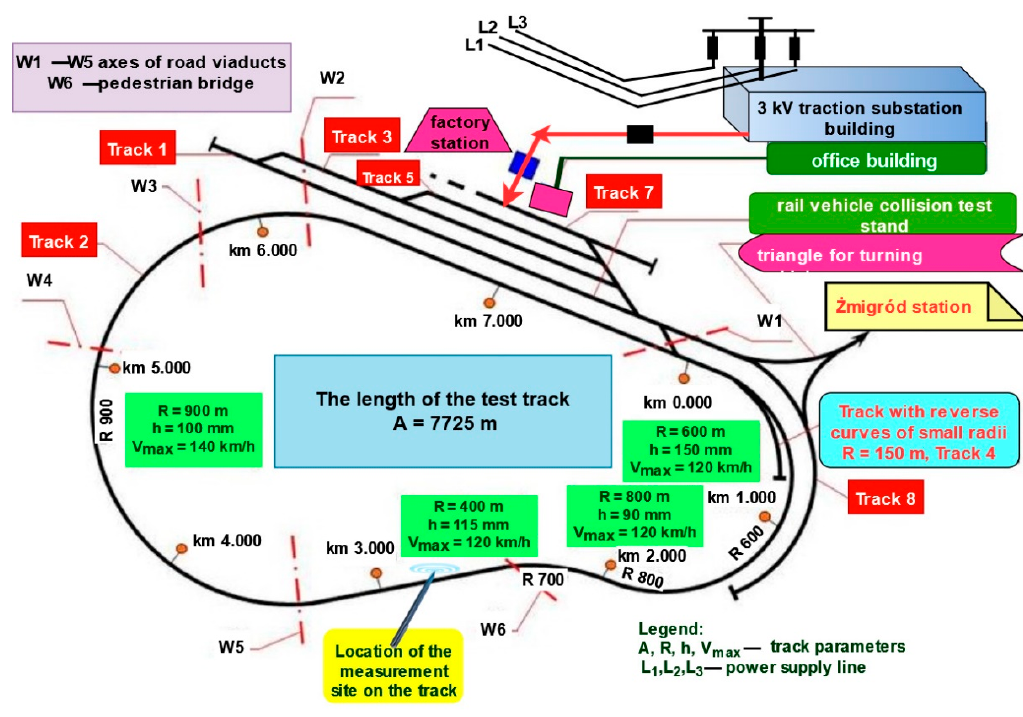
Figure 4. The Railway Institute’s test track located near Ż migród. The measurement point of radiated interfering signals is marked in the figure.